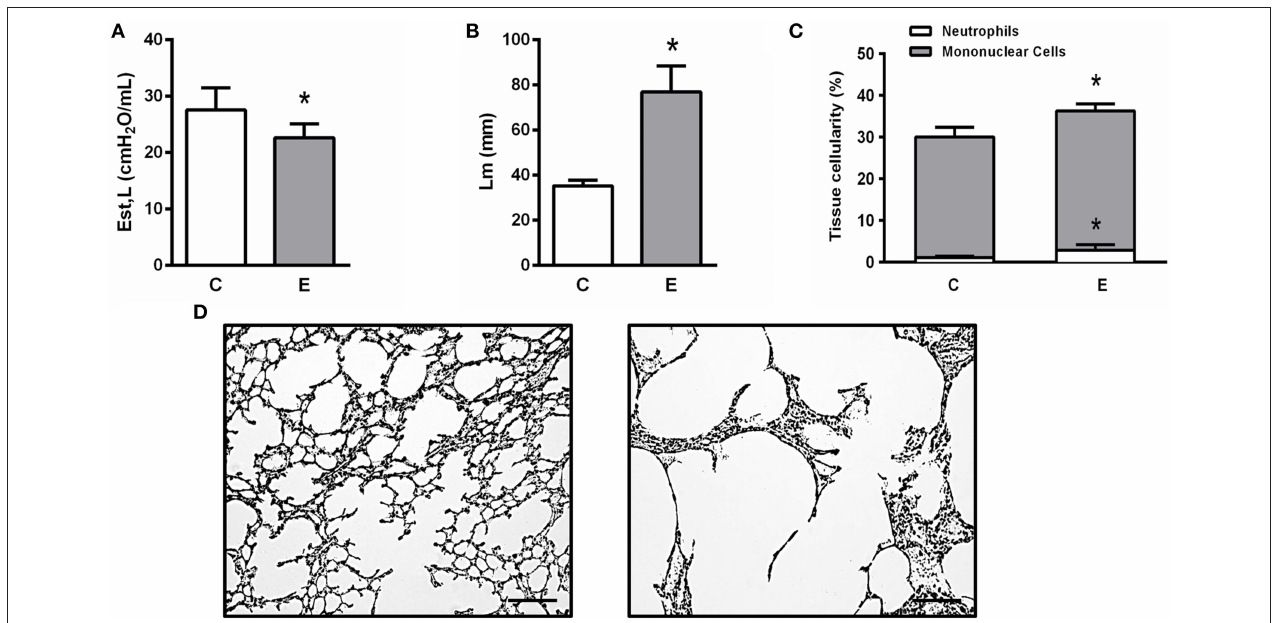
FIGURE 2 | Static lung elastance (Est,L) (A), mean linear intercept (Lm) (B), mononuclear cells, neutrophils, and total cells in lung tissue (C), and representative photomicrographs of lung parenchyma stained with hematoxylin-eosin. Note enlargement of alveolar space in the Egroup (arrow) (D) . Presence of pulmonary emphysema on day 21 was analyzed in two groups (C,E) . C, mice received intratracheal saline and were analyzed on day 21; E, mice received intratracheal porcine pancreatic elastase and were analyzed on day 21. * Significantly different from C ( p < 0.05 ).